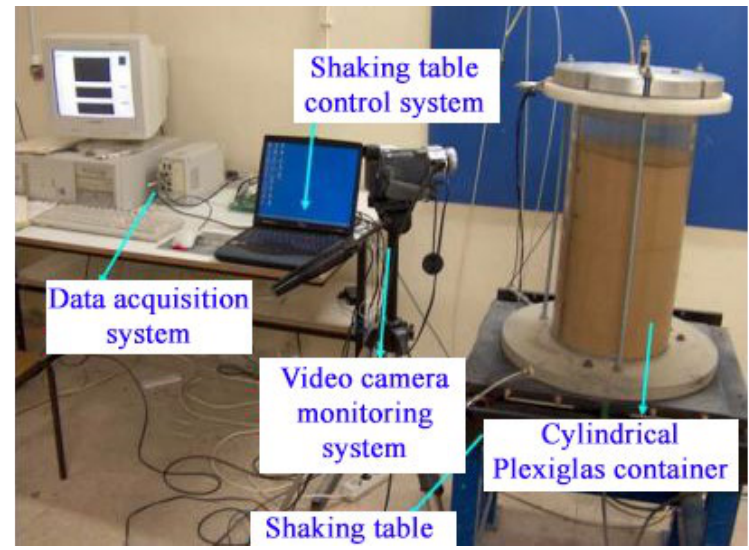
Figure 2. General view of the experimental test (From [40]; modified).